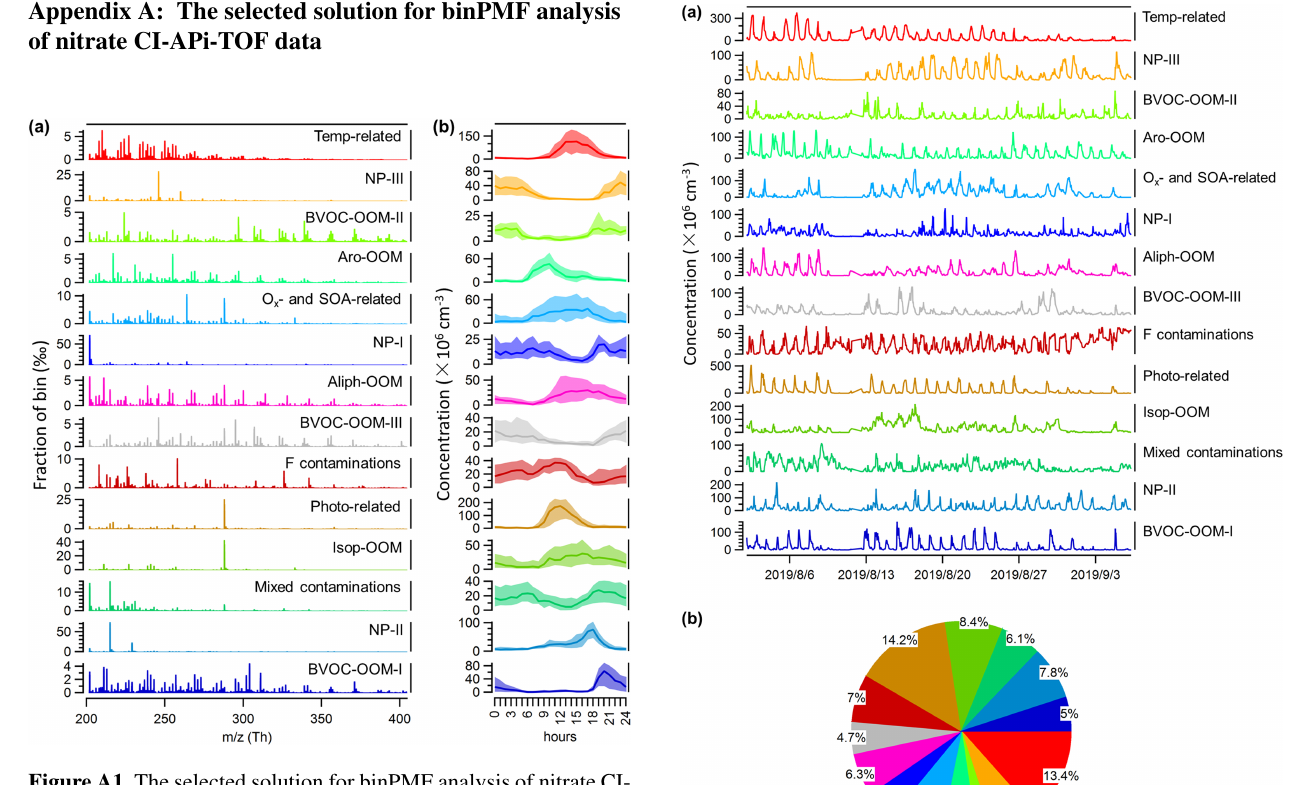
Figure A1. The selected solution for binPMF analysis of nitrate CI- APi-TOF data, showing the (a) mass profile and (b) diurnal cycle of different factors.